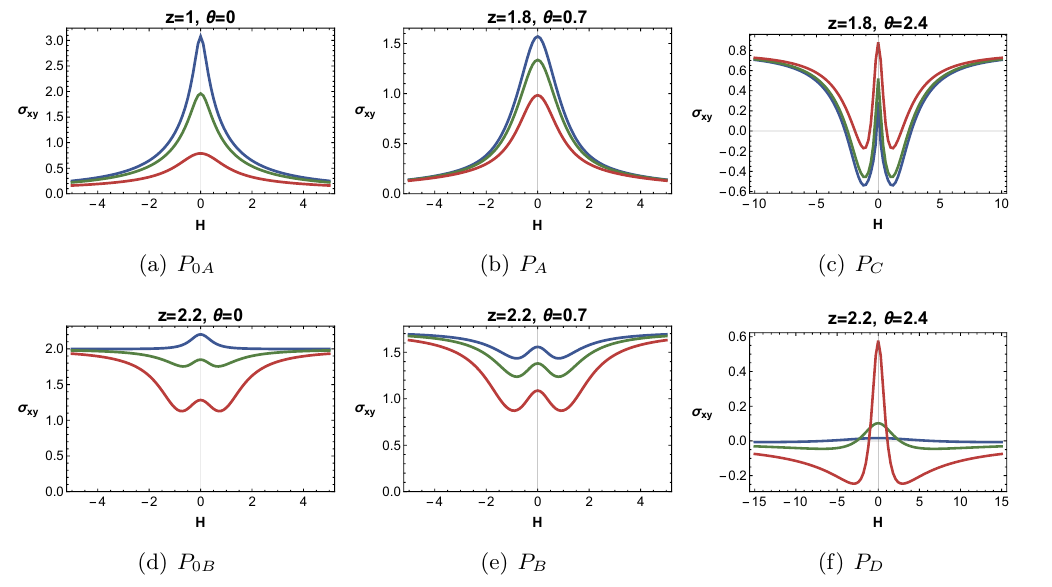
Figure 8 . Temperature evolution for (cid:27) xy ( H ) for di(cid:11)erent ( z; (cid:18) ). Curves correspond to T = 0 : 04 ; 0 : 1 ; 0 : 24 for blue, green, and red respectively. We used q (cid:31) = 0 : 7.